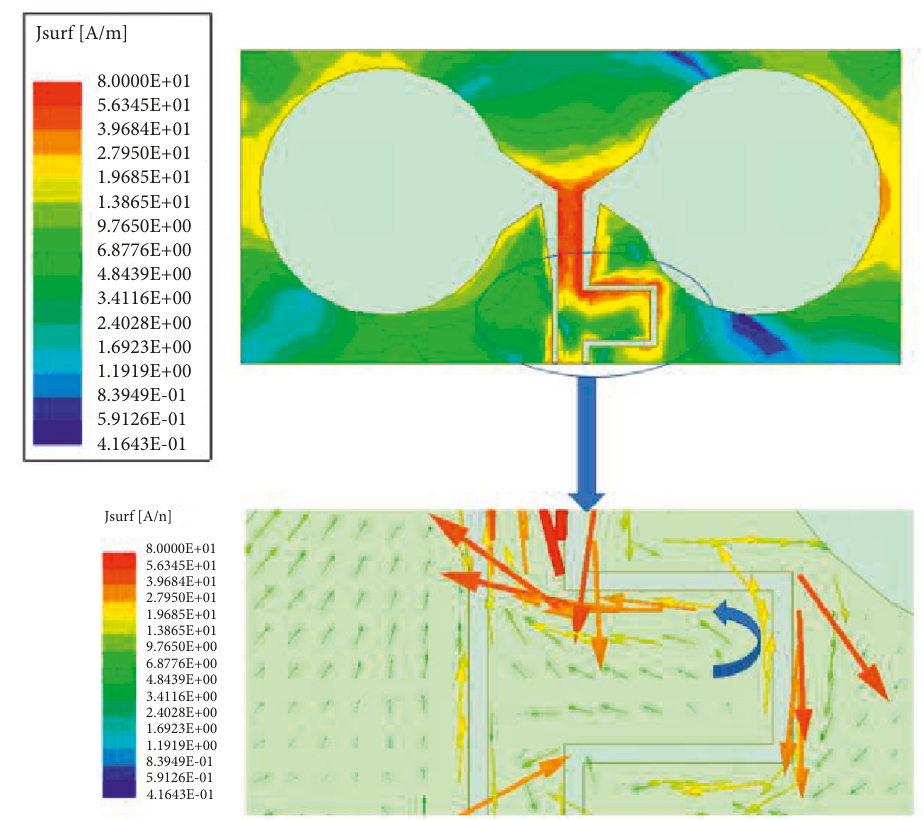
Figure 12: The surface current distribution of antenna 4 at